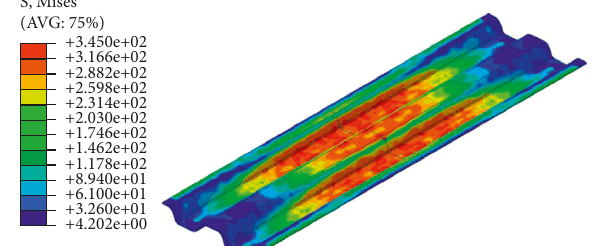
Figure 15: Stress of the steel plate in the ultimate limit state.